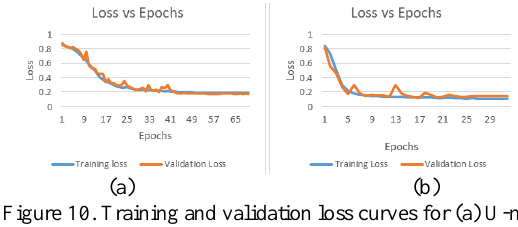
Figure 10. Training and validation loss curves for (a) U-net model 1 and (b) U-net model